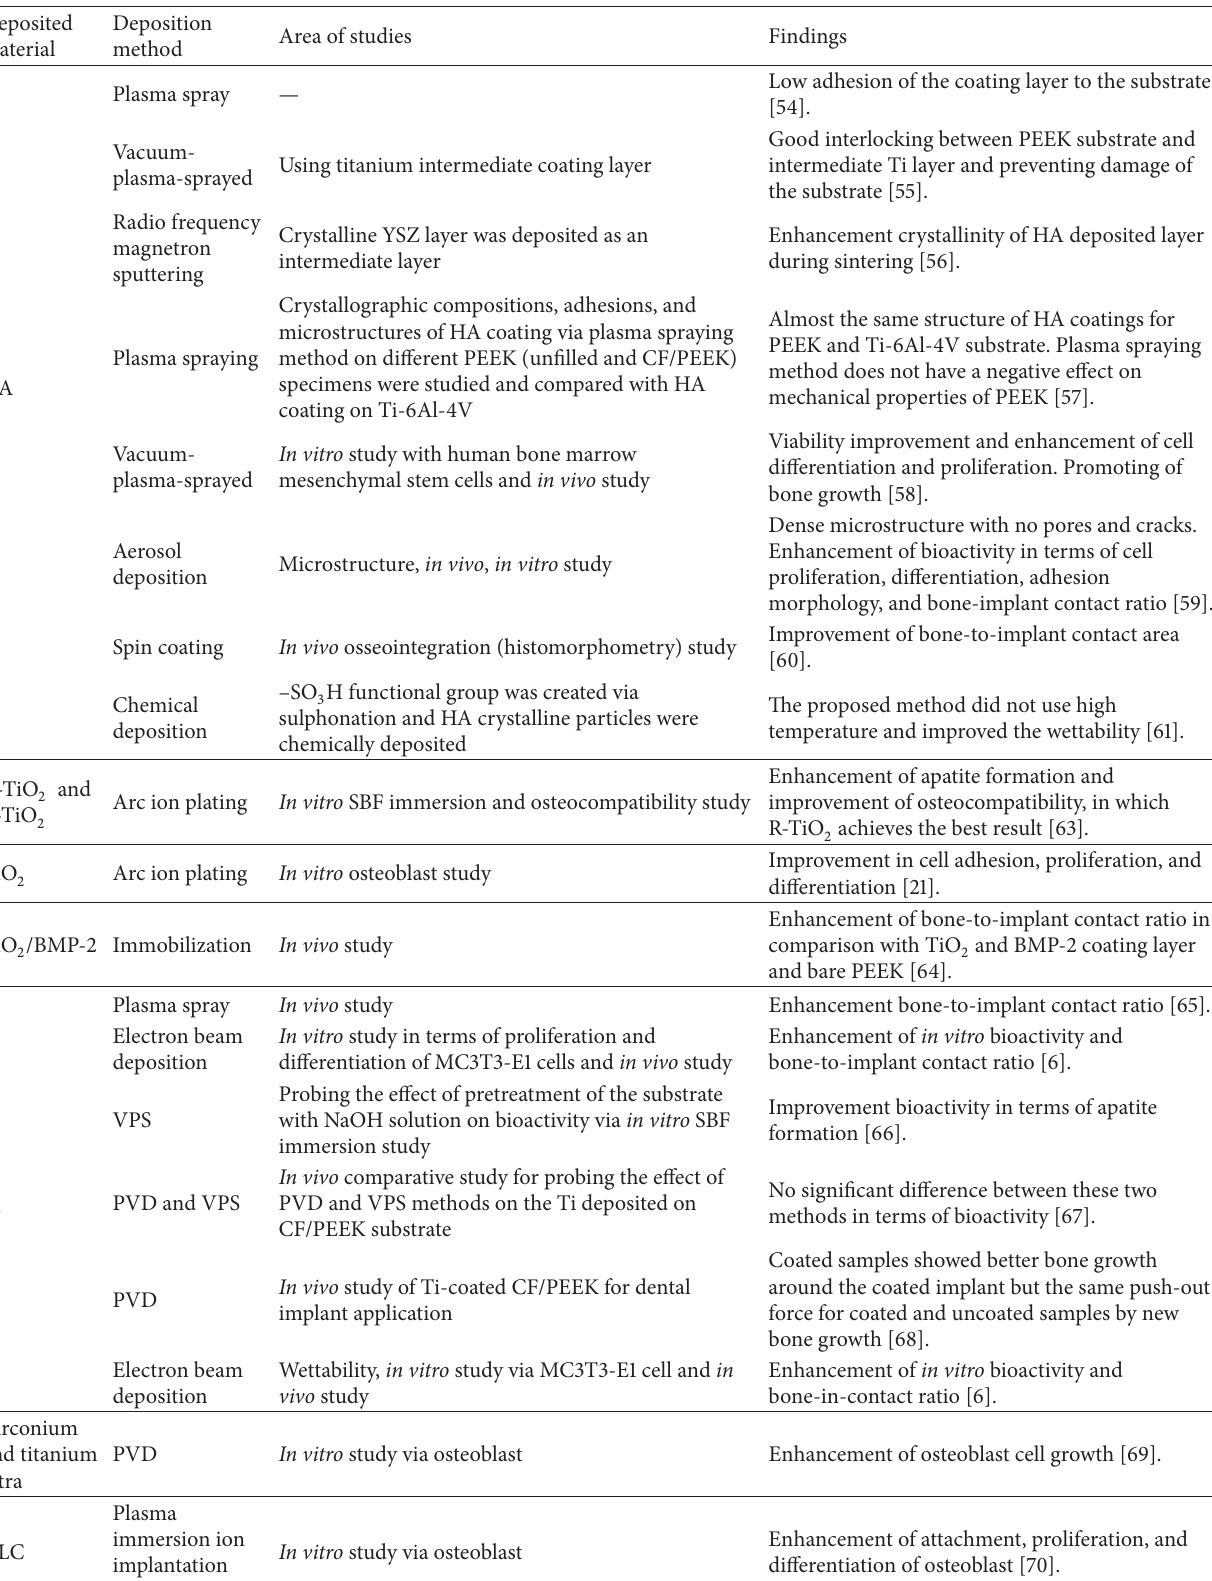
Table 3: Summary of the existing deposition methods/materials for improving PEEK